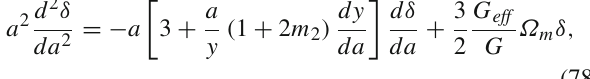
Fig. 1 Evolution of Ω m ( a ) and Ω DE ( a ) (upper graph) and the deceler- ation parameter q ( a ) (lower graph) as functions of the scale factor a for several different values of the parameter n . At the present time, a = 1 ( z = 0), the fractional densities of dark matter and dark energy take the values Ω m ( a = 1 ) ≈ 0 . 28 and Ω DE ( a = 1 ) ≈ 0 . 72, respectively. The Universe enters in the acceleration phase for q ( a ) < 0 at a ≈ 0 . 56. We also have added the Λ CDM predictions (red curve) in order to compare with the model at hand